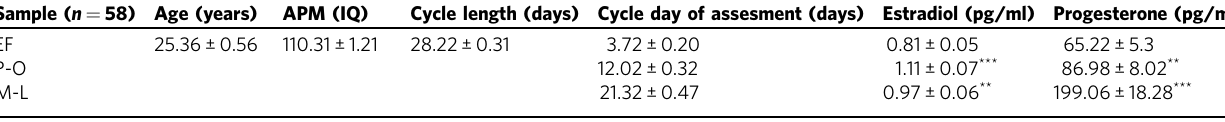
Table 1 Demographic data and hormone levels during each cycle